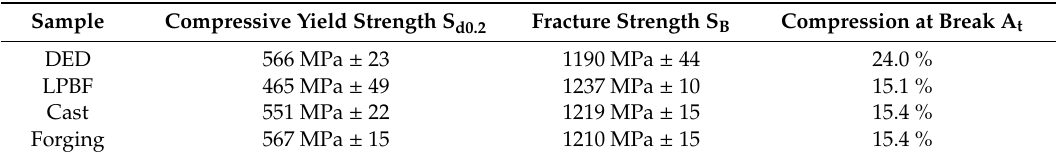
Table 5. Compressive strength of TNM-B1 samples at 700 ◦